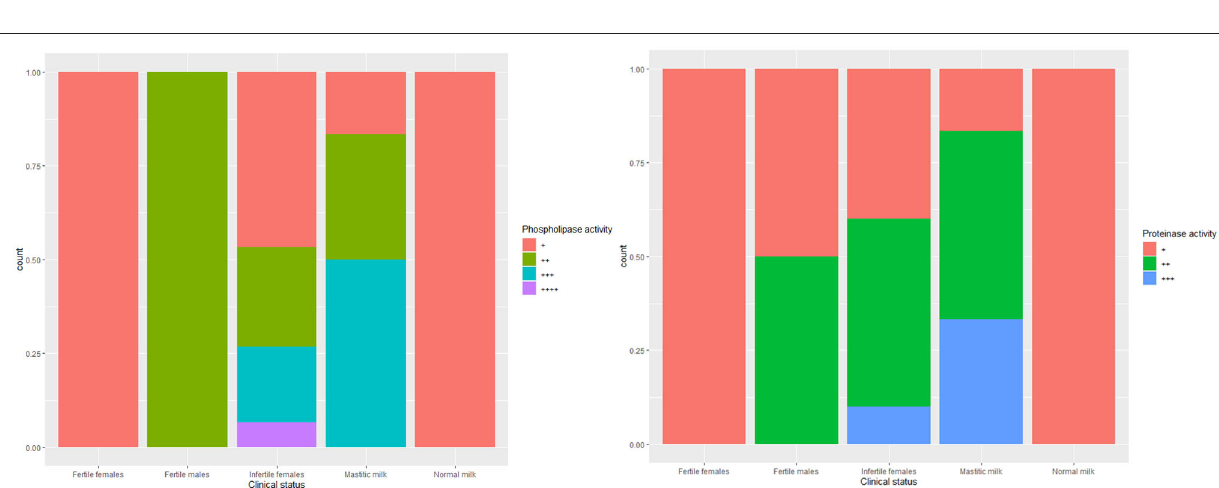
allows Candida to acquire iron from host tissues for metabolism, growth, and invasion during host infection (26, 52, 61).